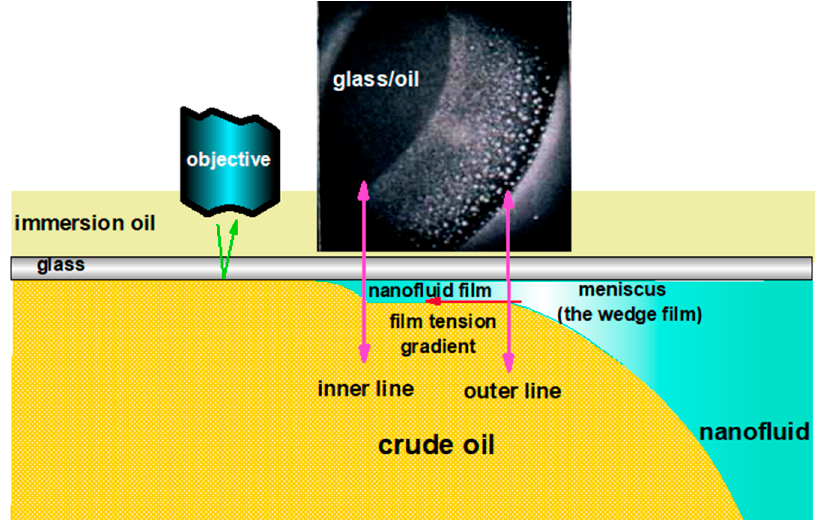
Figure 9. Photomicrograph taken using reflected-light interferometry to monitor the nanofluid’s displacement of oil from a solid surface. Reprinted with permission from [50]. Copyright 2012 American Chemical Society.